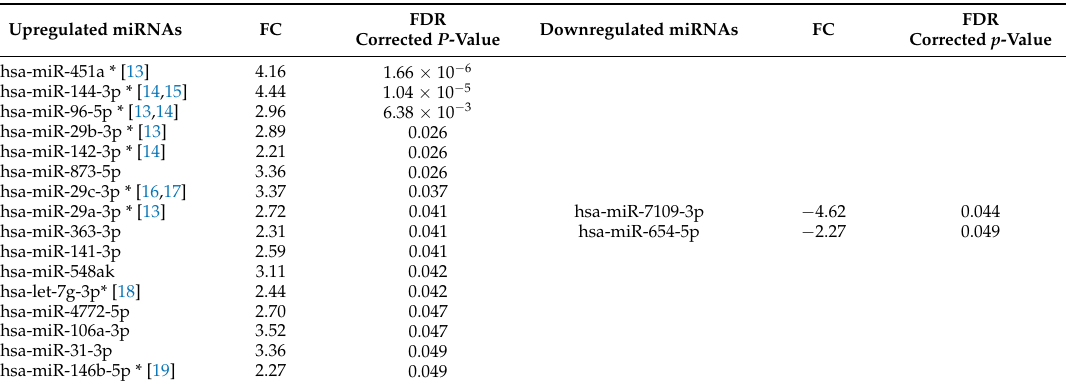
Figure 1. Heatmap of the normalized read counts which represent the hierarchical clustering of miRNA expression in each patient at the onset of the disease (T0) and after four weeks of steroid treatment (T4). Table 1. Differentially expressed miRNAs.